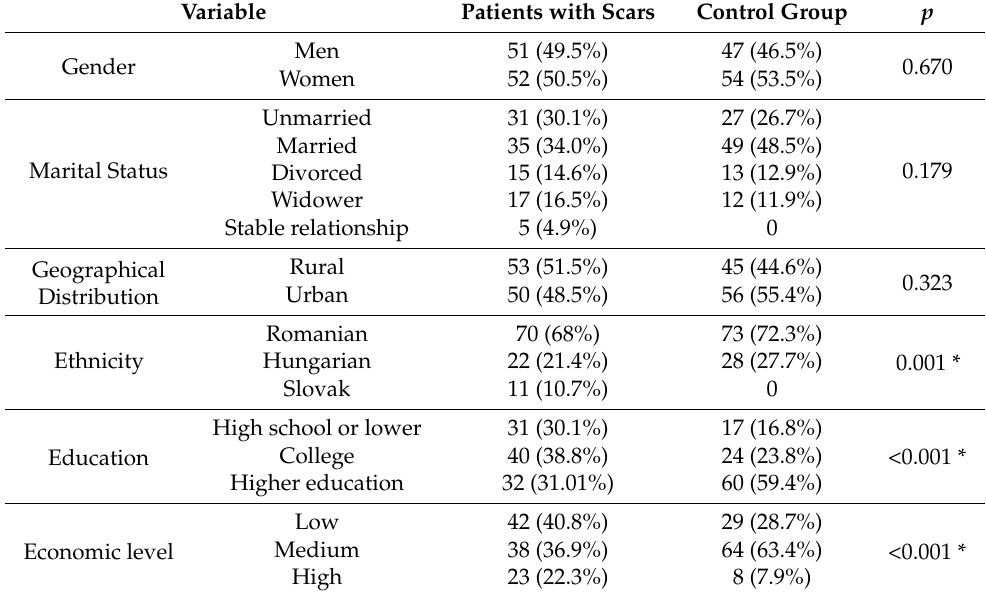
Table 1. Demographic data for the group of 103 patients with scars and of the control group ( n = 101).